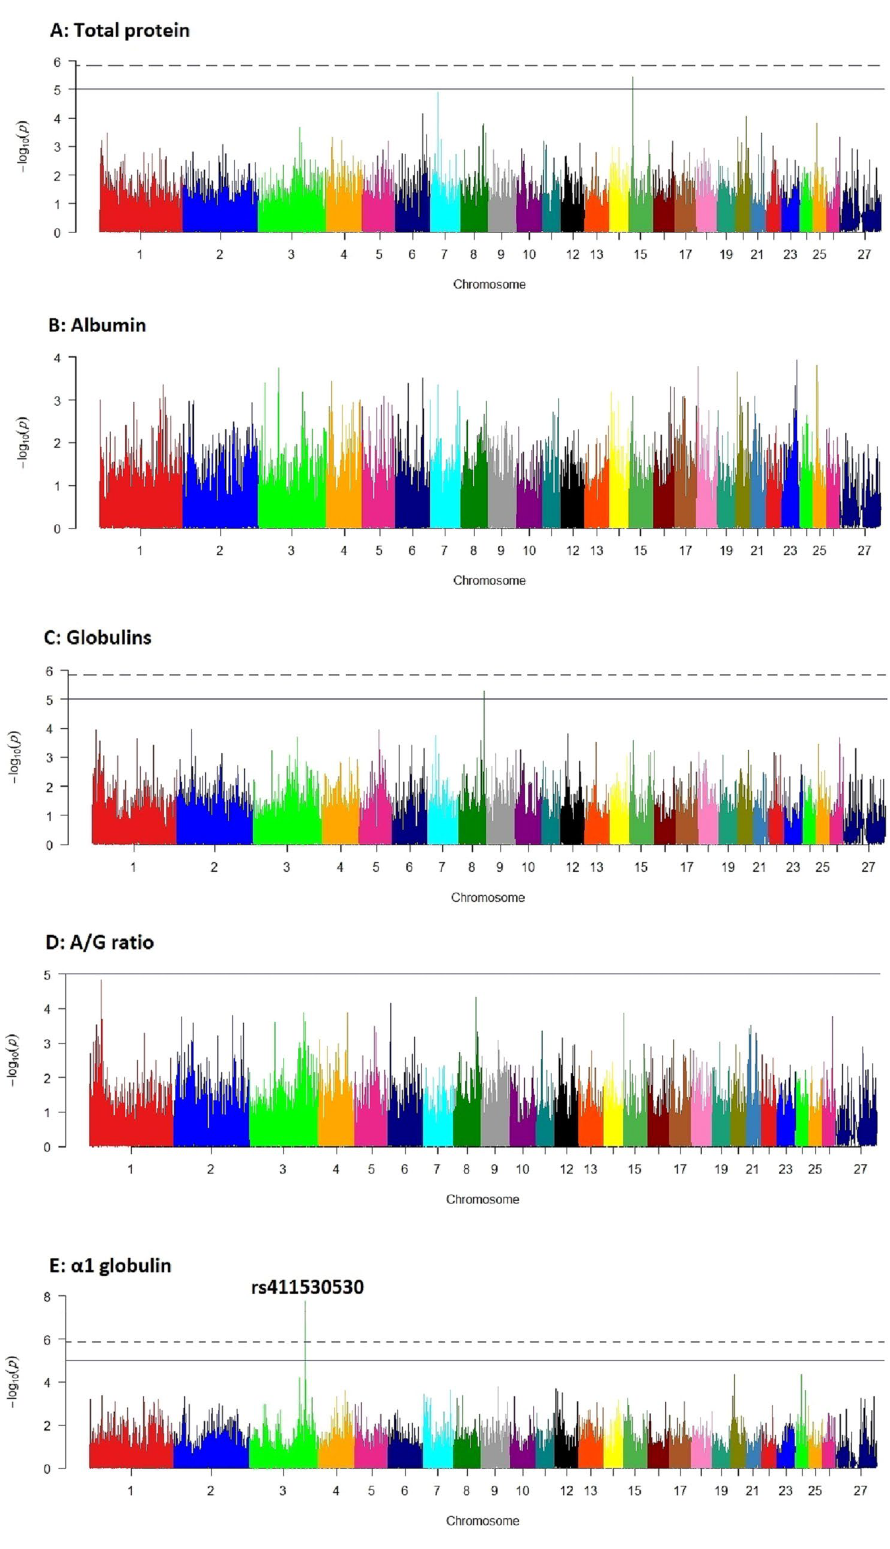
Figure 3. Manhattan plots of genome-wide − log10 ( p values) for the studied traits. Solid and dashed horizontal 5 6 lines show genome-wide p values of 10 − and 1.19 × 10 − (Bonferroni adjusted p value = 0.05), respectively; A: total protein, B: albumin, C: globulins, D: albumin/globulin ratio, E: α1 globulin, F: α2 globulin, G: β globulin, H: γ globulin and I: